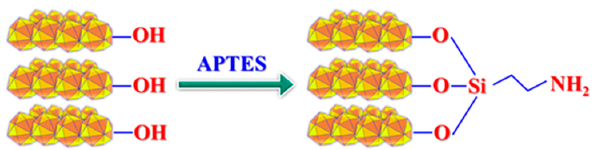
Figure 2. Diagram of modification of Laponite RD.